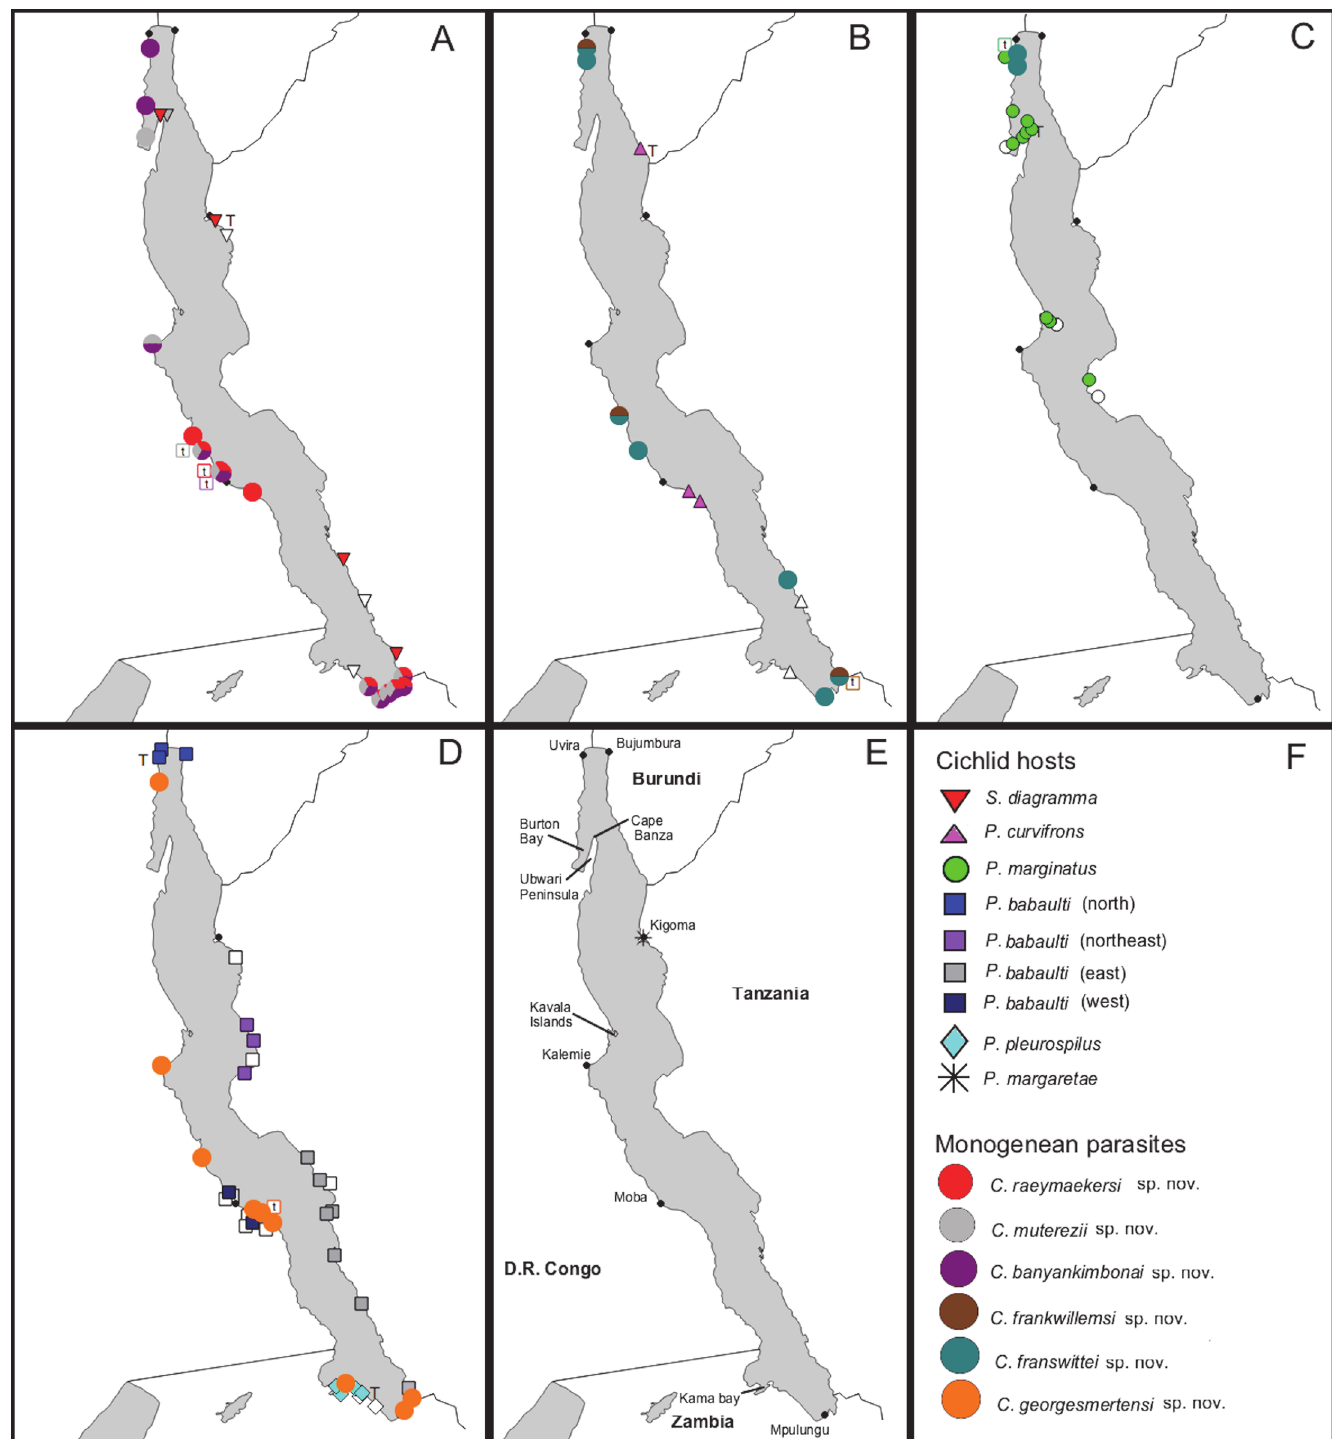
Fig 16. Map of Lake Tanganyika with an overview of specimens examined. Collection localities of hosts and parasites with: filled symbols: cichlids used for morphology, empty symbols: cichlids used for barcoding, pie charts: collection sites of Cichlidogyrus parasites, T: cichlid type locality and t: Cichlidogyrus type locality, for A. Simochromis diagramma , B. Pseudosimochromis curvifrons , C. P . marginatus , D. P . babaulti (including its junior synonym P . pleurospilus ), E. P . margaretae (including localities mentioned in text) and F. symbols and colours used to denote collection sites of cichlids and of Cichlidogyrus